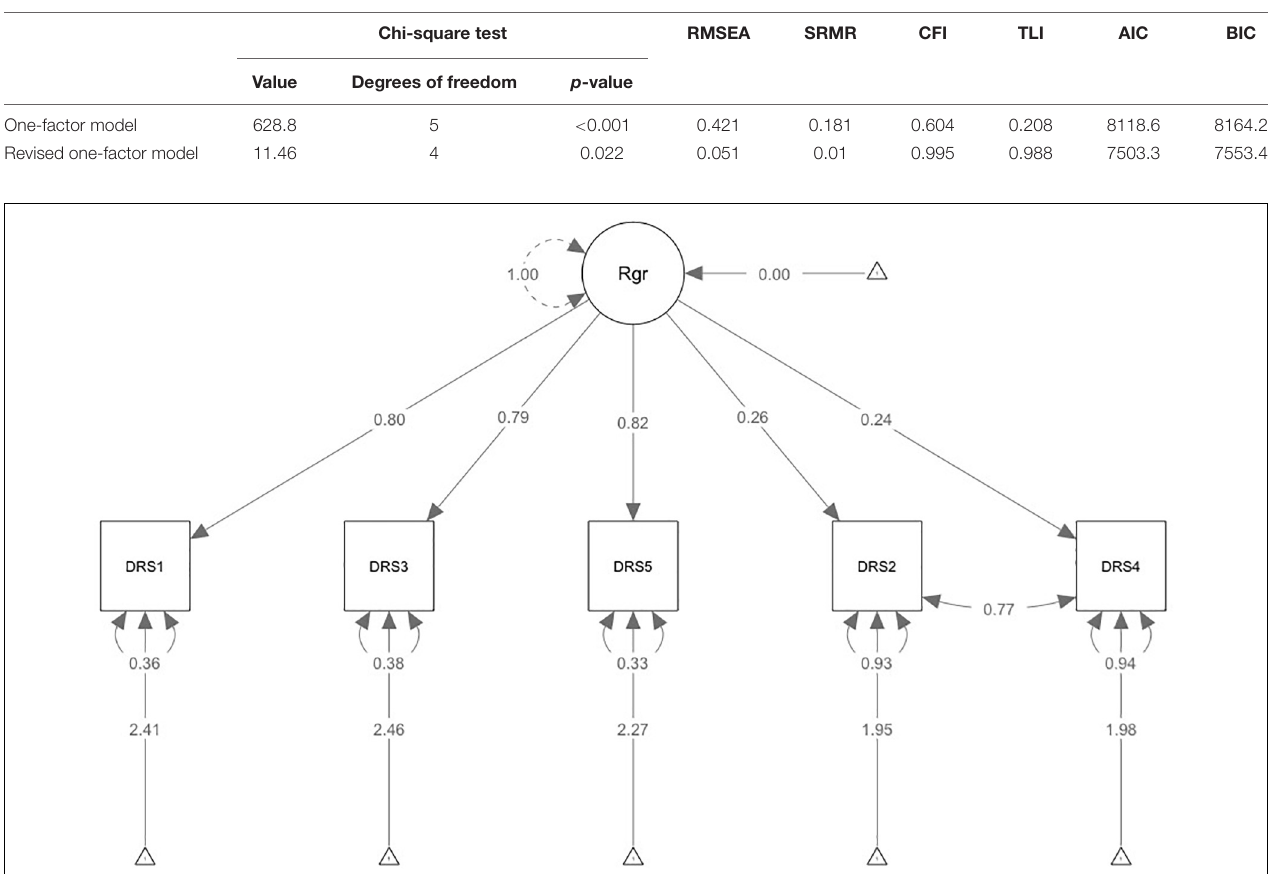
TABLE 2 | The CFA result of the DRSc.